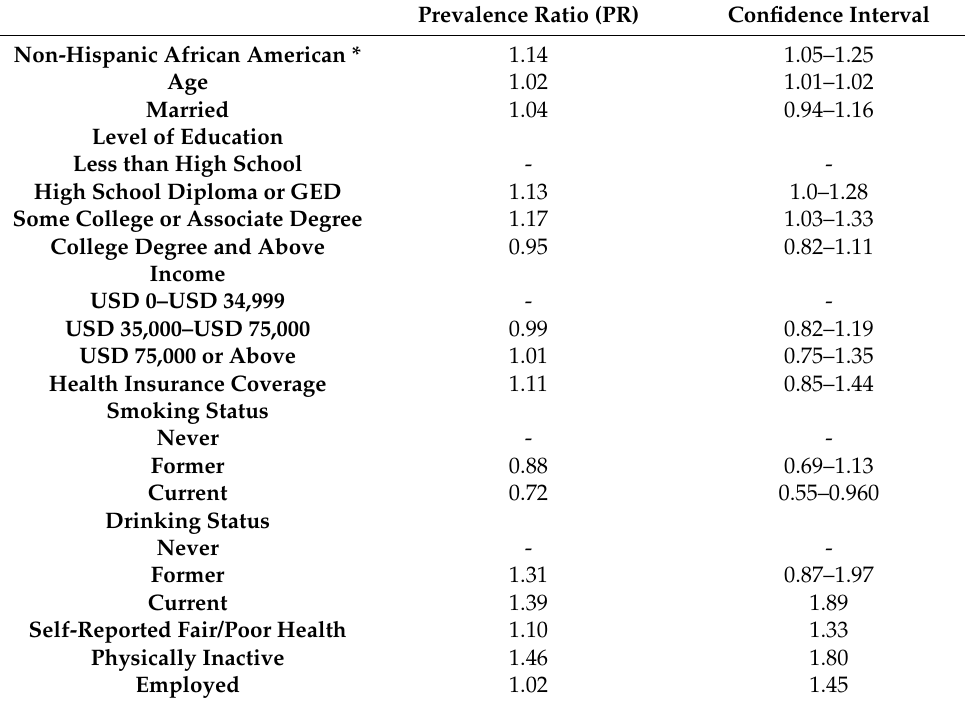
Table 2. Association between race and Allostatic Load among Non-Hispanic Black and Non-Hispanic White Men in the 1999–2016 NHANES.